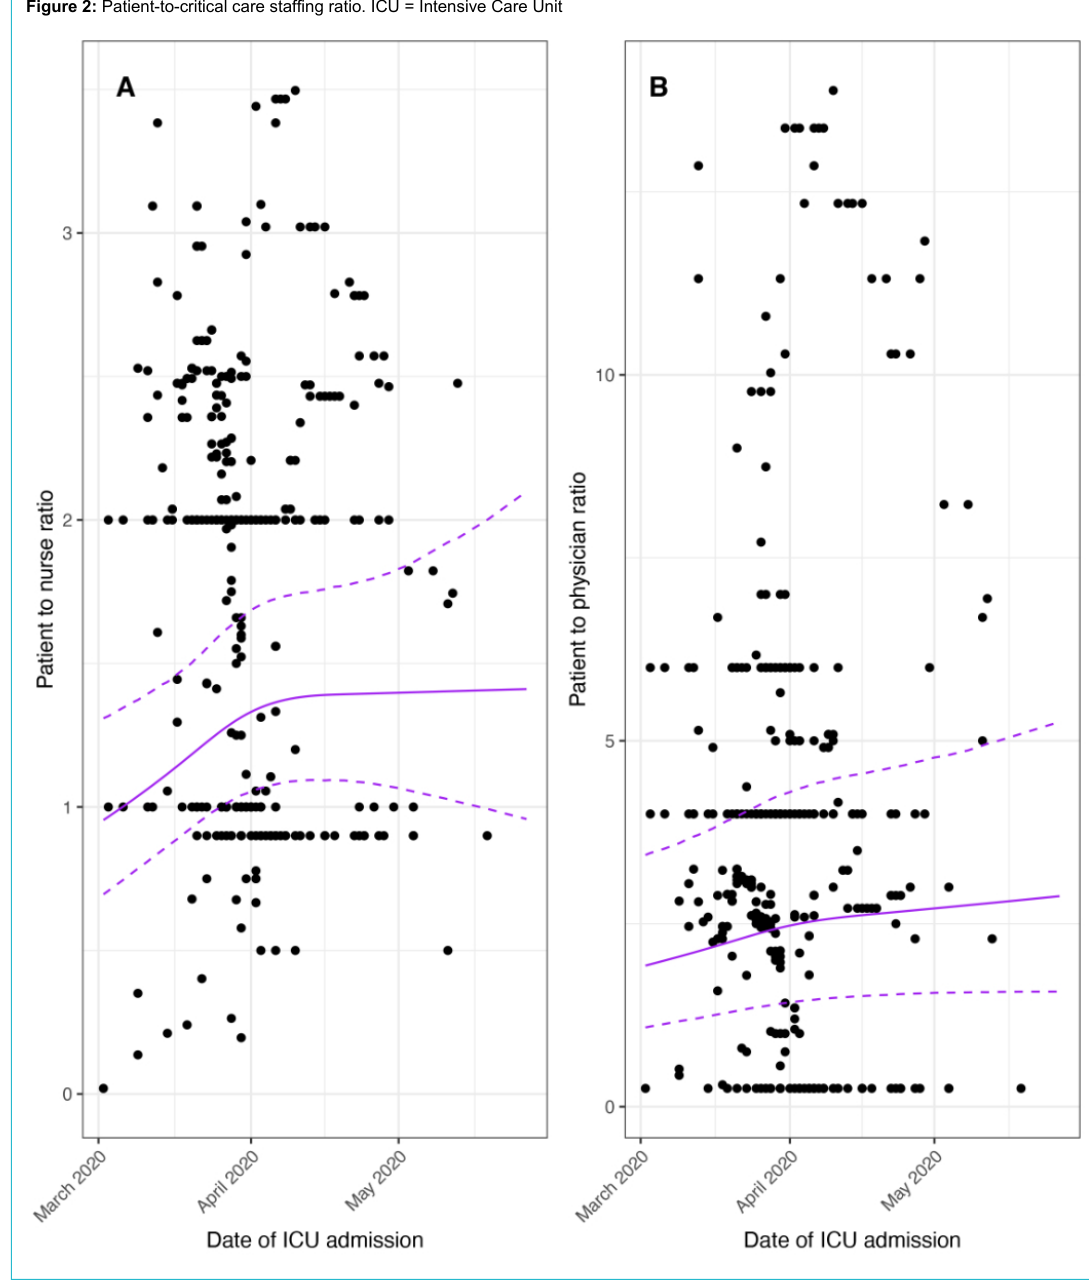
Figure 2: Patient-to-critical care staffing ratio. ICU = Intensive Care